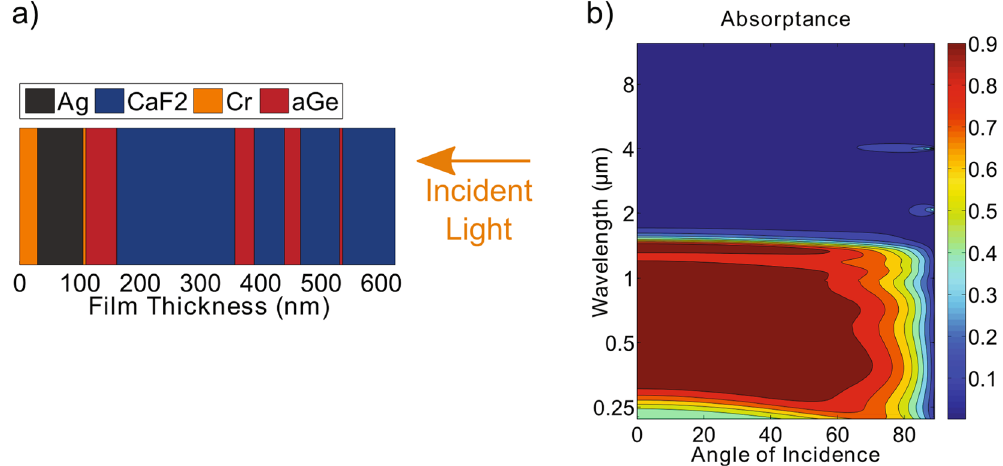
Figure 1. ( a ) Schematic of multilayer stack consisting of Ag, CaF 2 , Cr, and a Ge. ( b ) Contour plot of simulated absorptance versus angle and wavelength of incident light. The simulated solar absorptance and thermal emittance is 86.4% and 4.4%,